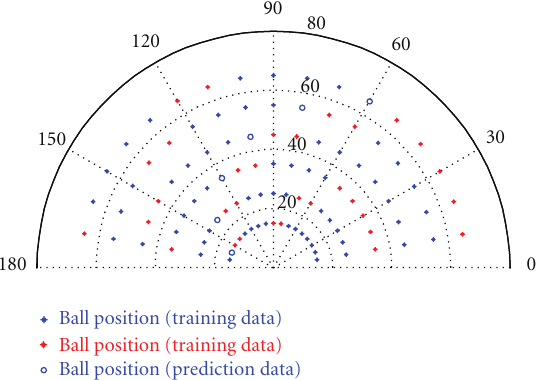
Figure 2: Initial target position for experimantal setup.